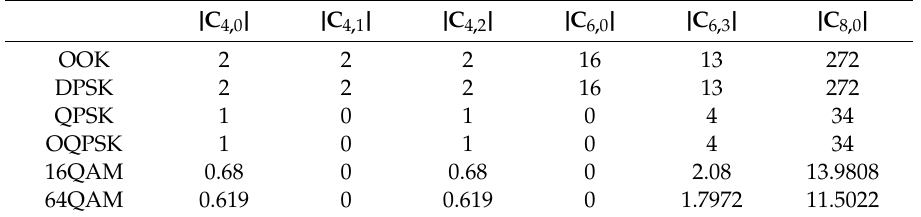
Table 1. Theoretical values of higher-order cumulant (HOC) for six wireless signal